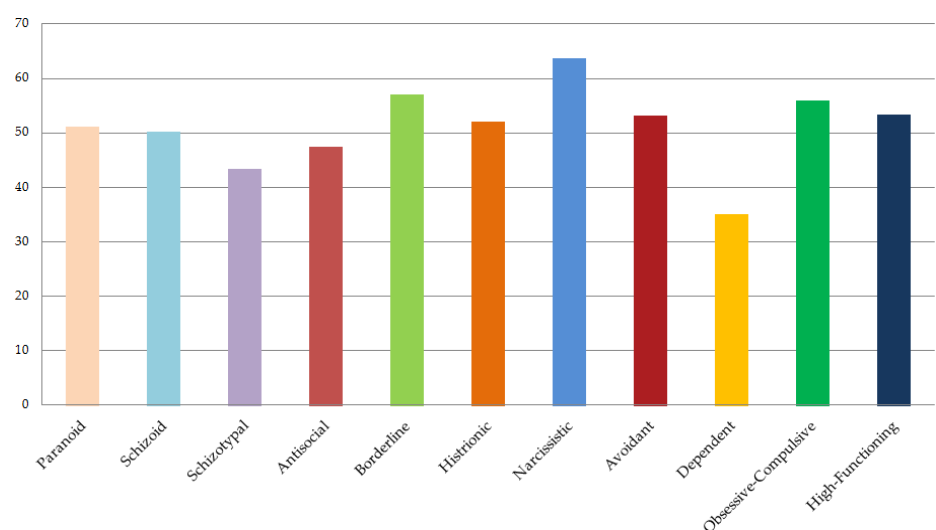
Figure 1. The personality profile (PD scales) derived from the SWAP-II-A shows that Albert presents an emerging narcissistic personality syndrome and an average high-functioning score.